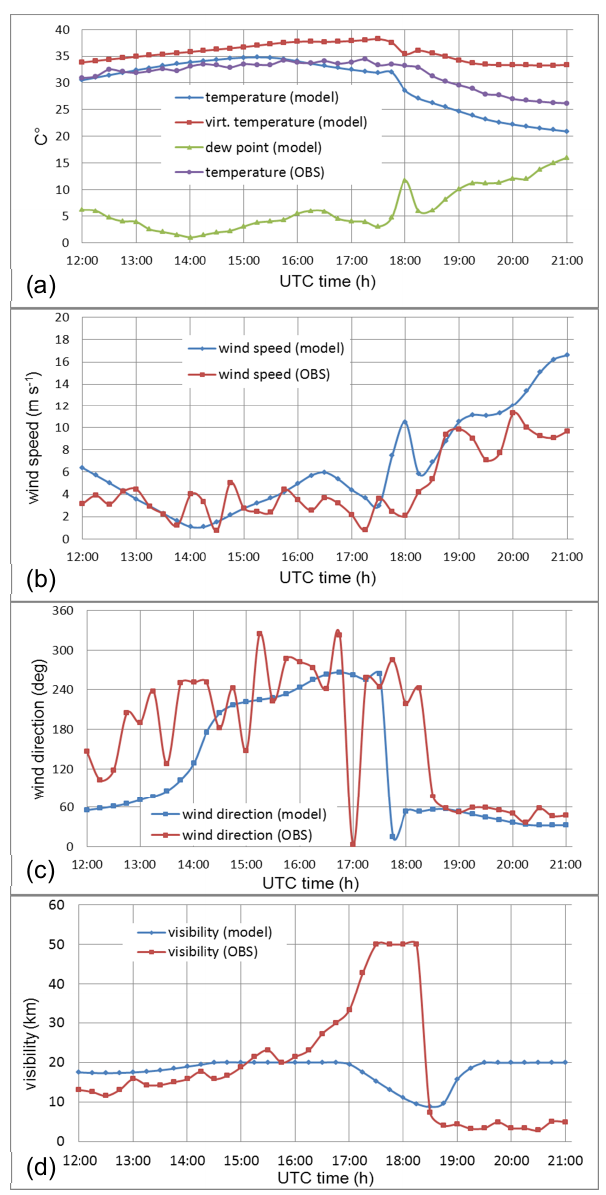
Fig. 12. Time series of observations and model results at Tinfou station. (a) Temperature, dew point and virtual temperature ( ◦ C) (b) Wind direction (deg) (c) Wind speed (ms − 1 ) and (d) Visibility (km).